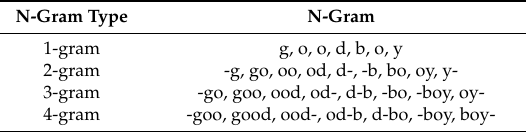
Table 7. Example of the decomposition of a sentence into character